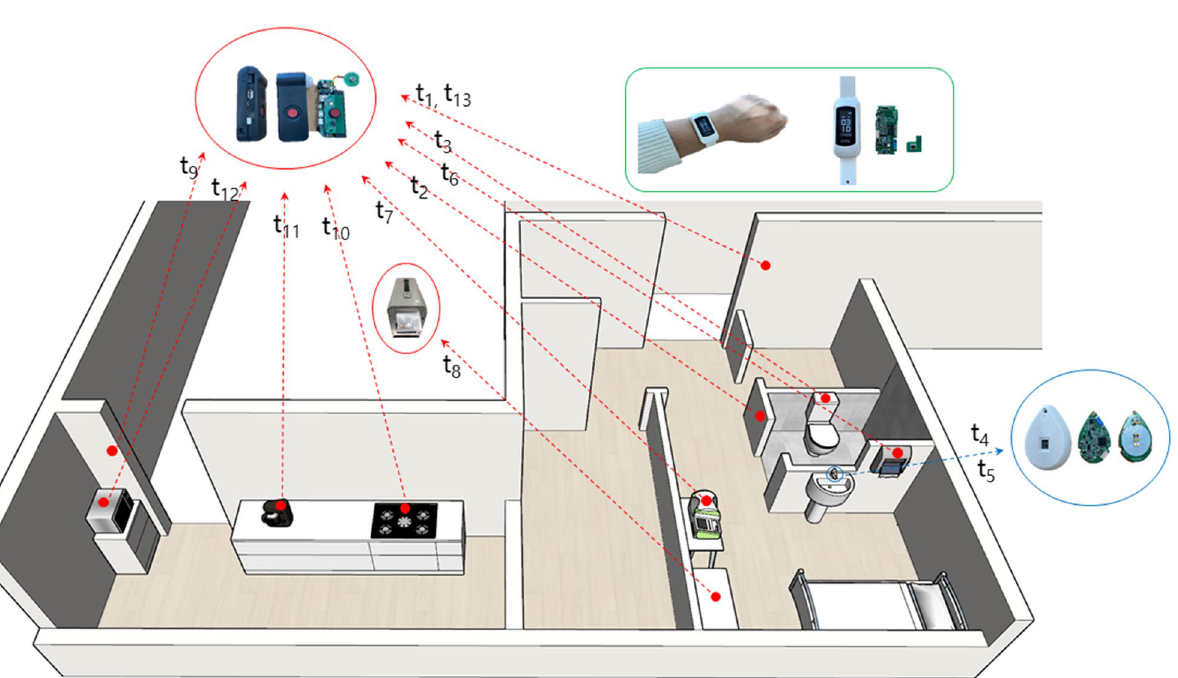
Figure 3. Illustration of the experimental devices and the ADL test environments. Red line; Stationary Resource Device, Blue line; External Sensor Device, Green line; Mobile identification Device (smart band). t1, t2…t13;